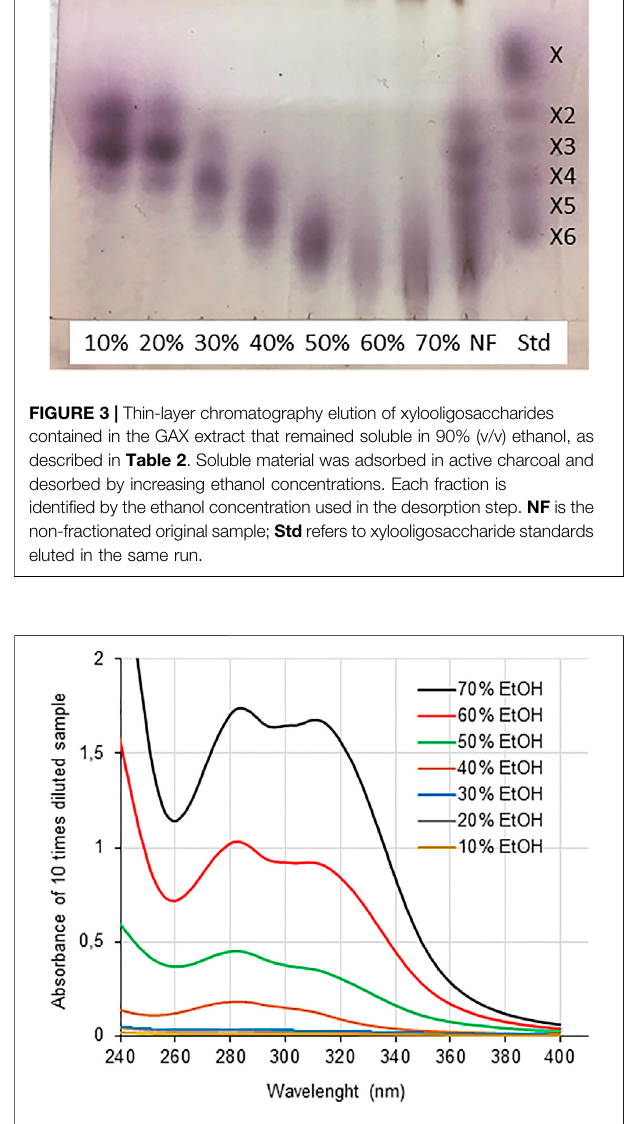
FIGURE 4 | UV spectra of GAX-derived fractions from the extract that remained soluble in 90% (v/v) ethanol, as described in Table 2 . Soluble material was adsorbed in active charcoal and desorbed by increasing ethanol concentrations. Each fraction is identi fi ed by the ethanol concentration used in the desorption